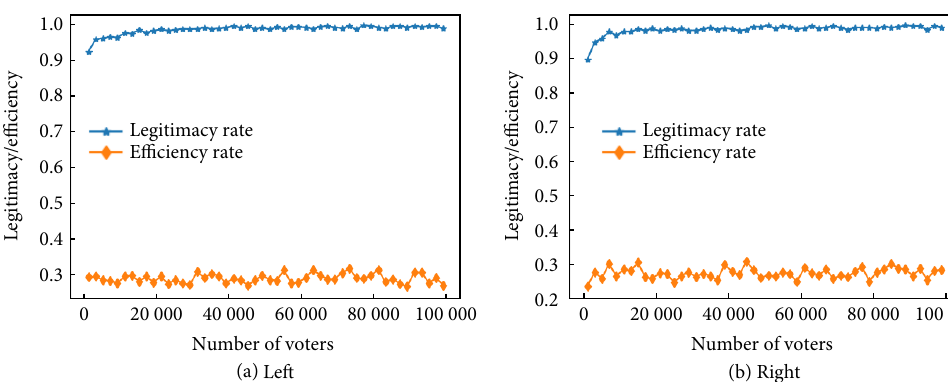
RightNumber of voters ( a ) L e ft (b) Fig. 13 Change curves of legitimacy/effciency when the numbers of candidates are 7 ((a) Left) and 8 ((b) Right).